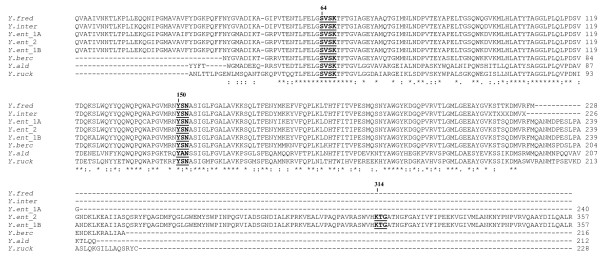
Amino acid sequence alignment of AmpC β-lactamase (Bla-B) of Y. intermedia (strain C-702) and Y. frederiksenii (strain C-115) and the nearest class C β-lactamase neighbors. Asterisks indicate identical amino acids. The conserved motifs (64SXXK67, 150YSN152 and 314KTG316) typical of class C β-lactamases are underlined and in boldface. The GenBank accession numbers of the β-lactamases are as follows: Y.fred and Y.inter (ABD84040 and ABD84041, present study),Y.ent_1A (AAZ66331, Y. enterocolitica biovar 1A),Y.ent_2 (CAA44850, Y. enterocolitica, IP97 biovar 2), Y.ent_1B (Y. enterocolitica 8081 biovar 1B),Y.berc (AAO21212, Y. bercovieri), Y.ald (AAO21211, Y. aldovae) and Y.ruck (AAM94804, Y. ruckeri).